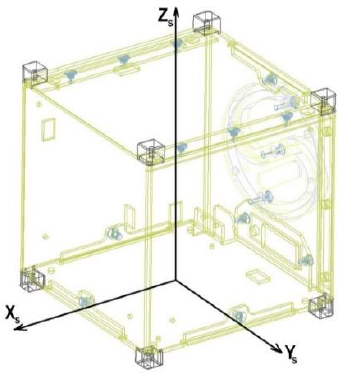
Figure 6. E-st@r-II body frame.